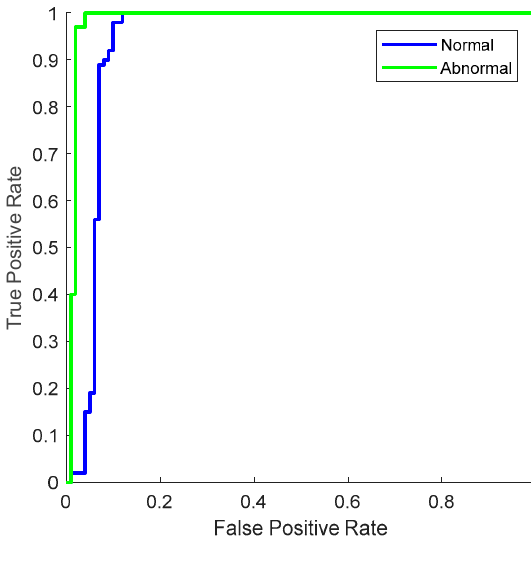
Figure 11. ROC for dataset 3.